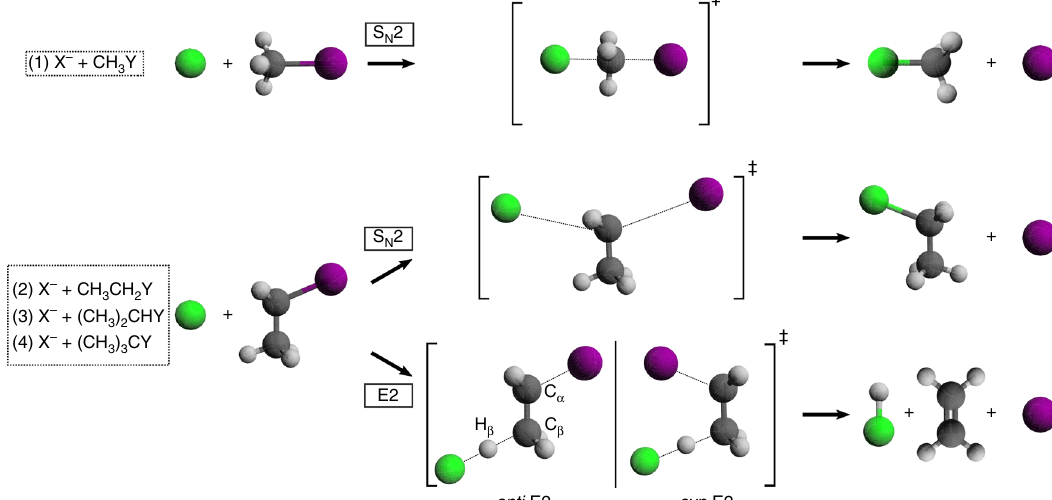
Fig. 1 Schematic representation bimolecular nucleophilic substitution (S N 2) and elimination (E2) mechanisms. For S N 2 the back-side attack TS is shown, whereas for E2 both the anti- and the syn -TSs are presented. Systems (1) – (4) represent the studied reactions with stepwise substituted alkyl